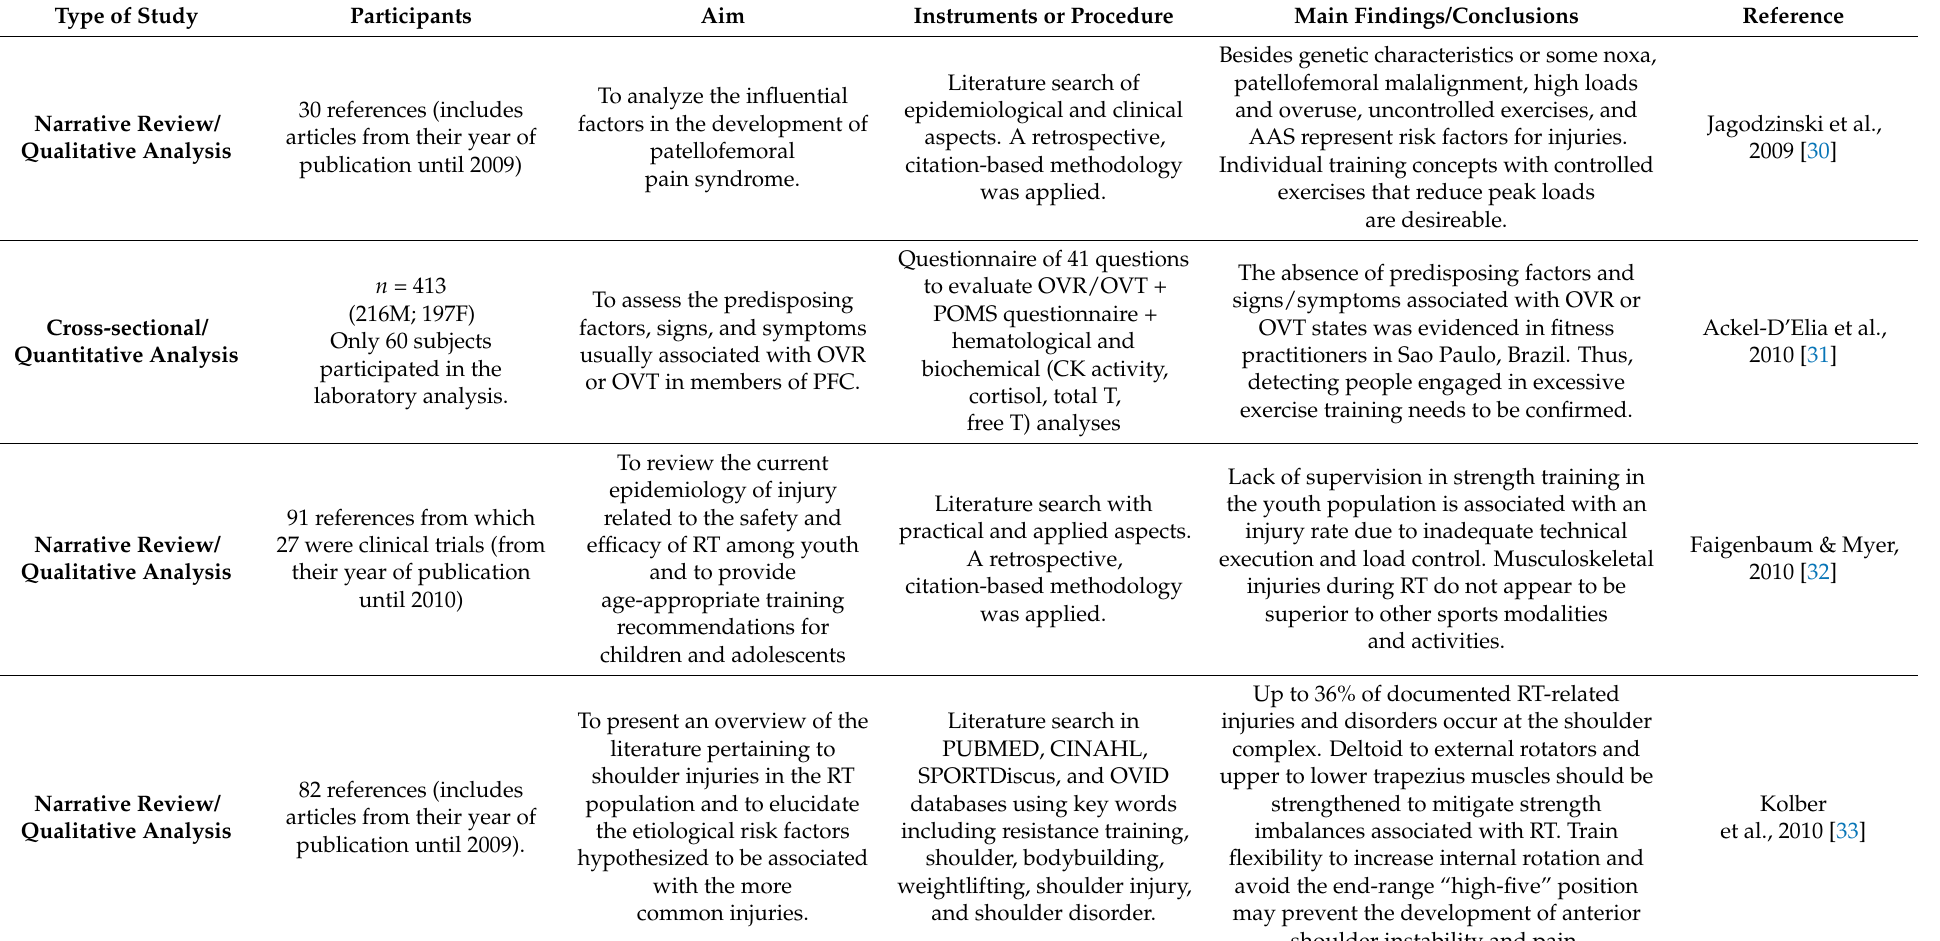
Table 1. Synthesis of the selected articles for the integrative